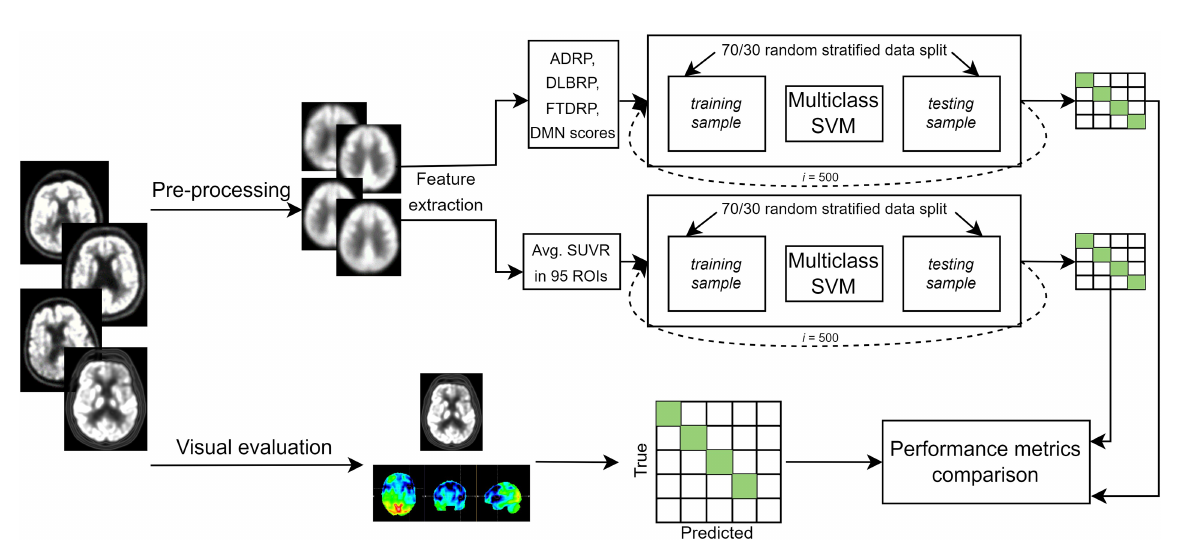
FIGURE 1 Flowchart of the general workflow. Top: 2-[ 18 F]fluoro-2-deoxy-D-glucose positron emission tomography (FDG PET) scans from three dementia cohorts and healthy participants underwent pre-processing, and two set of features [pattern expression scores and standard uptake value ratio (SUVR) in 95 regions of interest (ROIs)] were extracted. Two multi-class support vector machine (SVM) models were built to classify scans either as dementia due to Alzheimer’s disease (AD), dementia with Lewy bodies (DLB), frontotemporal dementia (FTD) or normal. Most common label after 500 iterations was compared to gold standard, and performance metrics calculated. Bottom: FDG PET scans were visually evaluated by two expert readers. Scans could be read either as AD, DLB, FTD, normal or other (inconclusive or other neurodegenerative pattern). Labels were compared to gold standard and performance metrics were calculated. Clinical diagnosis at follow-up or cerebrospinal fluid (CSF) biomarker for Alzheimer’s disease was considered a gold standard. ADRP, Alzheimer’s disease-related pattern; DLBRP, dementia with Lewy bodies-related pattern; FTDRP, frontotemporal dementia-related pattern; DMN, default mode network